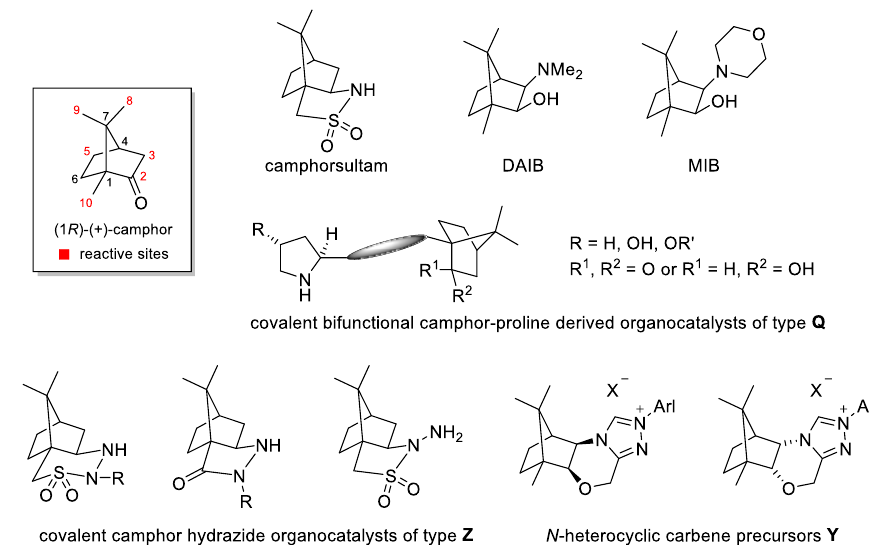
Figure 1. Selected examples of successful camphor-derivatives applied in asymmetric synthesis and catalysis.